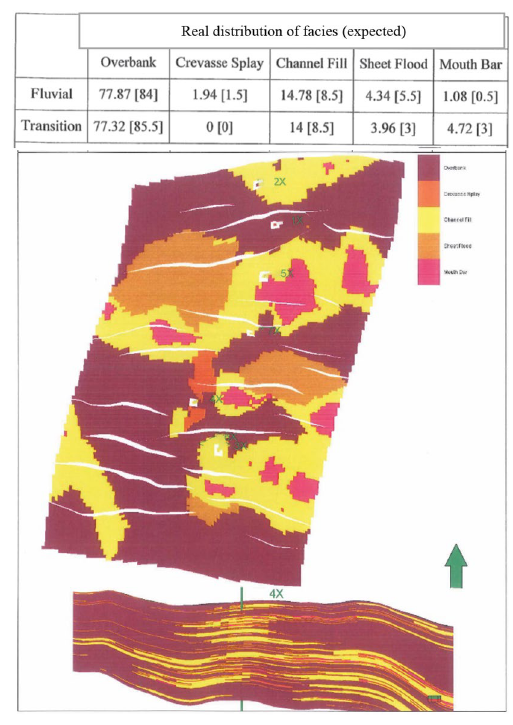
Fig. 24 Resulting model of case R1_1